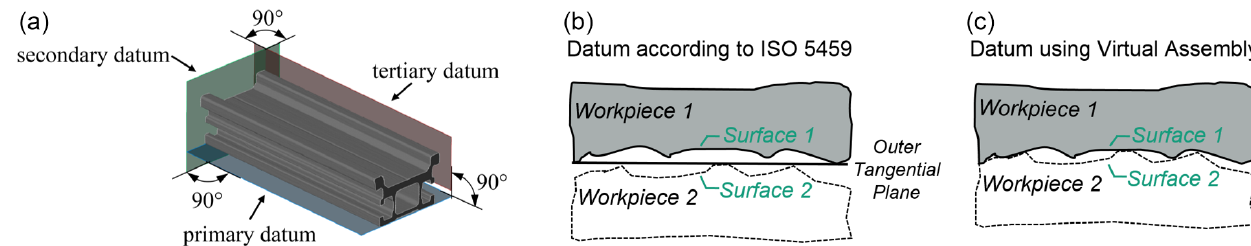
Figure 1. Datum definition by nested registration, using associated planes (a) , registration approach according to the default case in the current standard, (b) and registration approach according to virtual assembly (c)